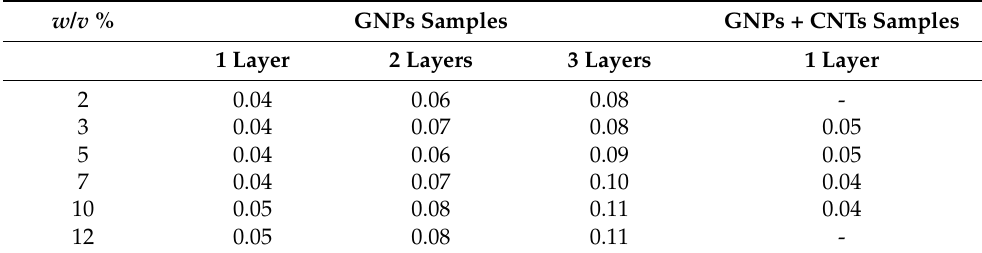
Table 2. Thickness of the films on the coated samples (mm).